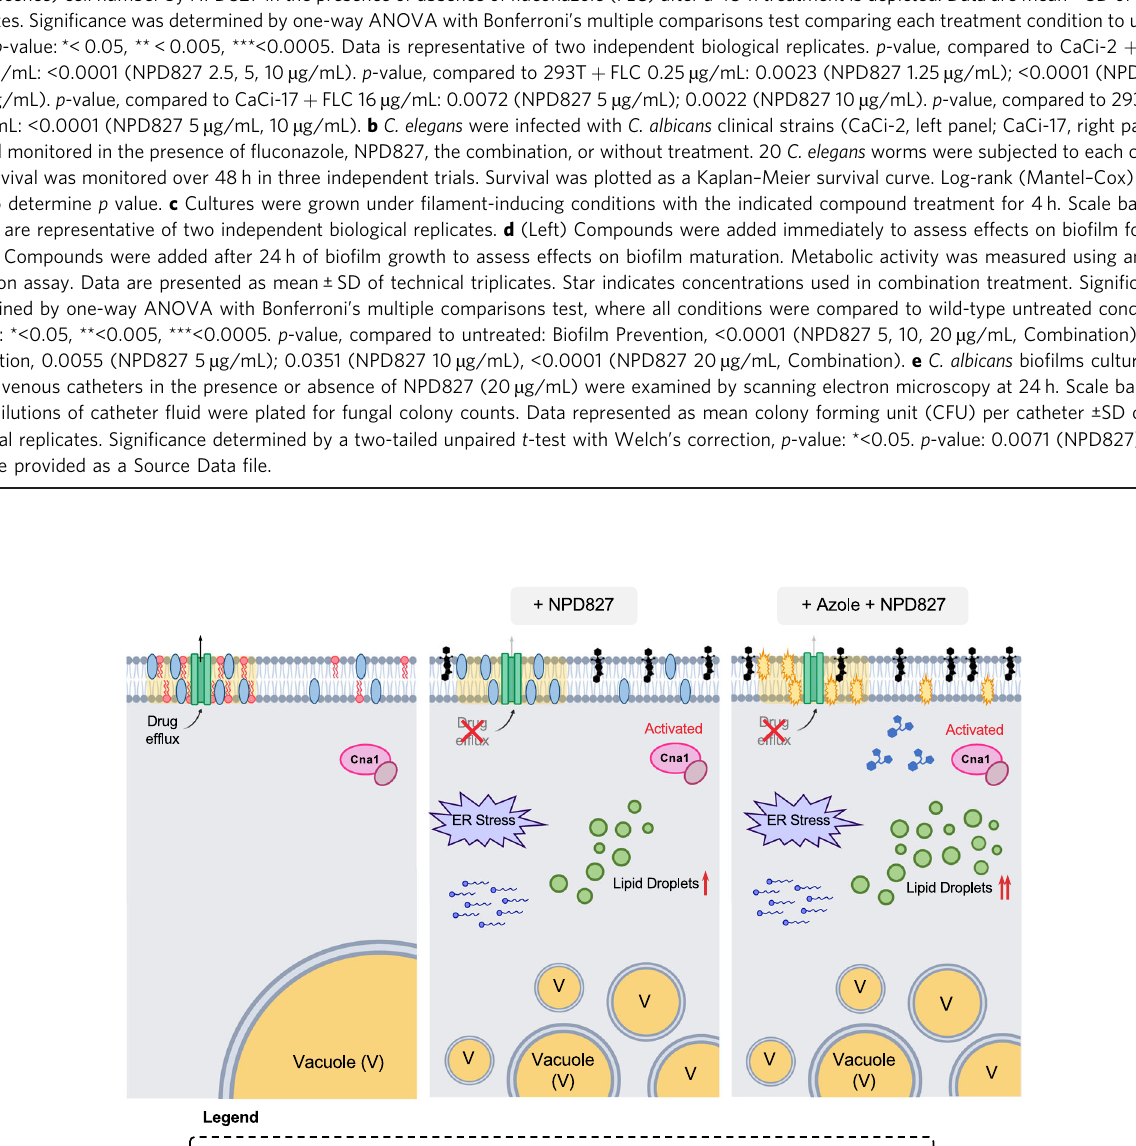
Fig. 8 Model of NPD827 mechanism of action. (Left) Under normal physiological conditions, ergosterol and sphingolipids exist within the plasma membrane as lipid microdomains (yellow shadow). These microdomains harbor membrane-bound proteins, including drug-ef fl ux pumps such as Cdr1. (Middle) NPD827 inserts into the plasma membrane and alters the biophysical properties of the membrane, reducing lateral mobility and impairing the function of membrane-bound proteins (i.e., Cdr1). Internalization of NPD827-associated membrane fragments disrupts the endomembrane system and induces vacuolar fragmentation, thereby perturbing lipid recycling throughout the cell. This disruption results in accumulation of toxic long-chain sphingoid bases, depletion of downstream sphingolipids, such as OH-Ceramide and Glucosylceramide, and induction of membrane-associated stress responses (i.e., lipid droplets, UPR, calcineurin-dependent stress responses). (Right) Due to impairment of drug-ef fl ux by Cdr1, fl uconazole accumulates within the cell further perturbing lipid homeostasis. The combination of effects ultimately halts growth of C. albicans in a synergistic